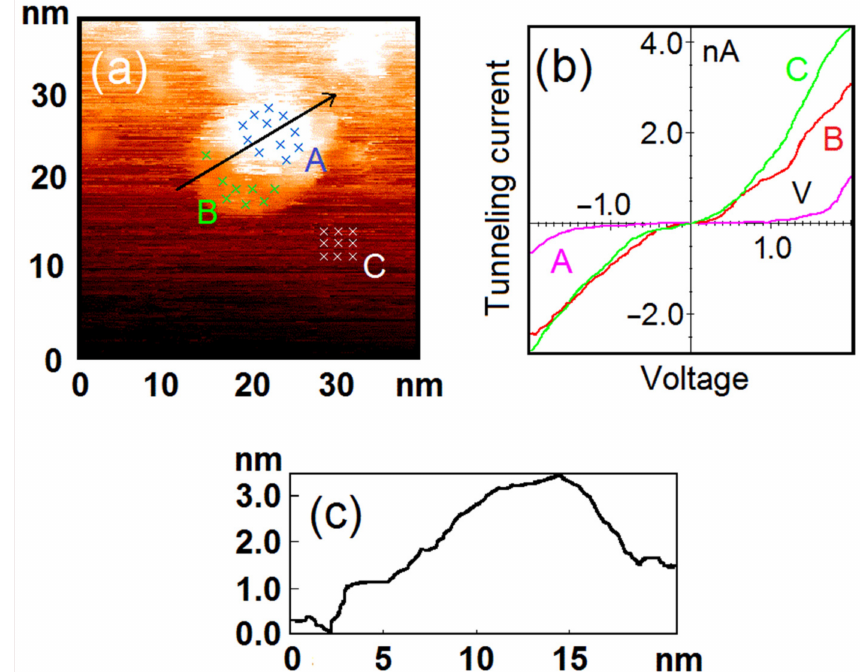
Figure 4. The mantle-possessing nanoparticle after exposure to O 2 (50 L). Results of the STM/STS measurement: ( a ) topography image of HOPG surface with deposited nickel nanoparticle; ( b ) VAC curves of the tunneling currents averaged over the set of points on the surface of HOPG (green curve C), central (pink curve A) and mantle (red curve B) areas of the nanoparticle marked with crosses in ( a ); ( c ) profile of the nanoparticle surface along the cut line shown in ( a